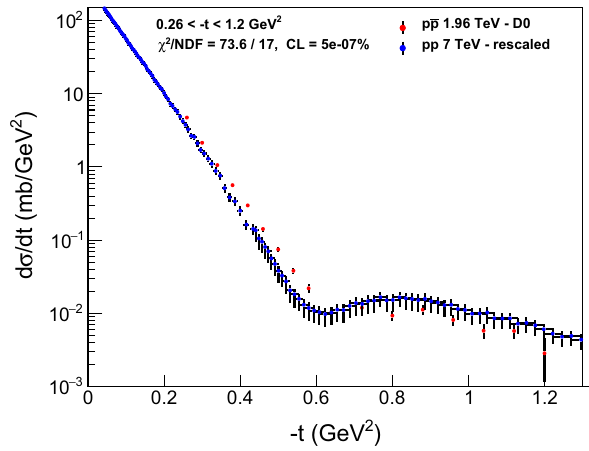
Fig. 8 Rescaling of the differential cross section of elastic pp colli- √ s = 7 to 1 . 96 TeV using Eq. (67). We have sions from the energy of evaluated the confidence level of the comparison between the rescaled 7 TeV pp data set and the 1.96 TeV p ¯ p data set with the help of Eq. (60), that does not take into account the horizontal errors of x coming from the slopes B and the type C point-to-point correlated errors on the ver- tical scale. Without these important effects, the difference between the datasets provides a χ 2 / NDF = 73 . 6 / 17, equivalent to a confidence level of CL = 5 . 13 × 10 − 7 % and a statistically significant, 5 . 84 σ